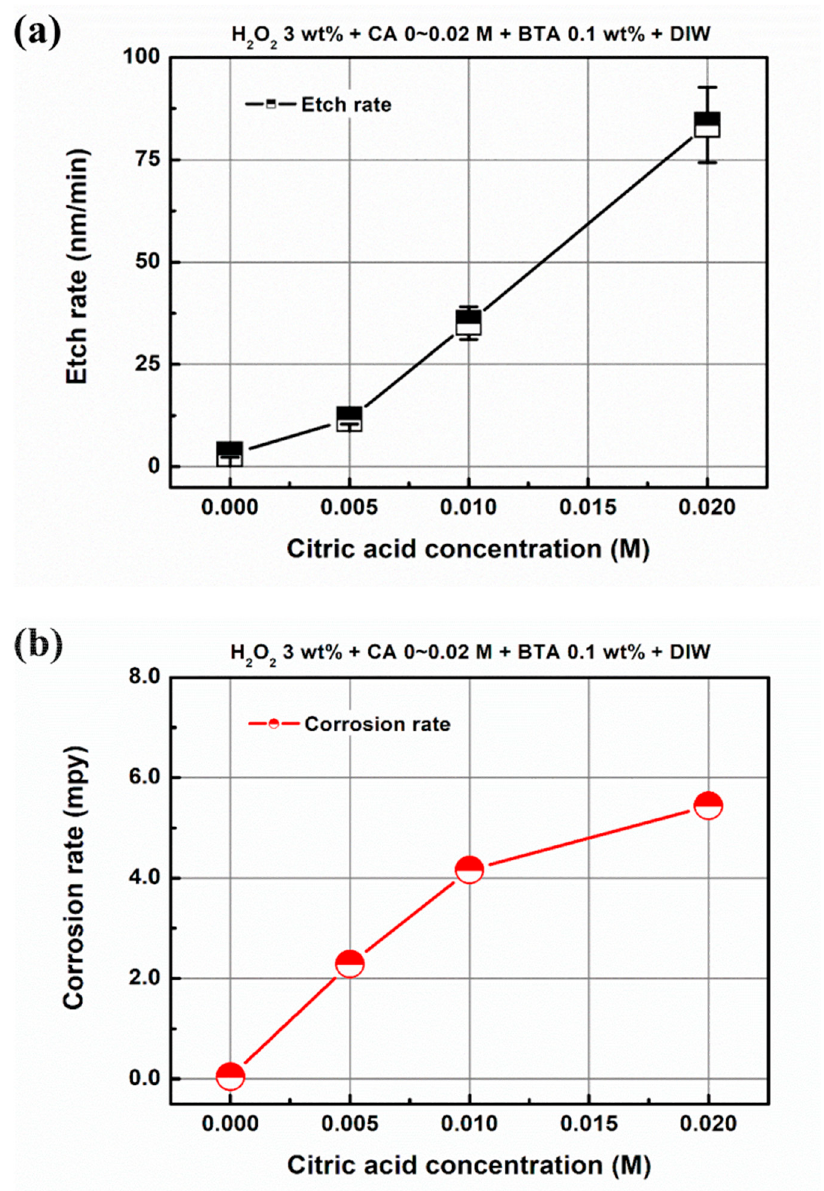
Figure 11. Etch rate and corrosion rate as a function of citric acid concentration; ( a ) etch rate and ( b ) corrosion rate.